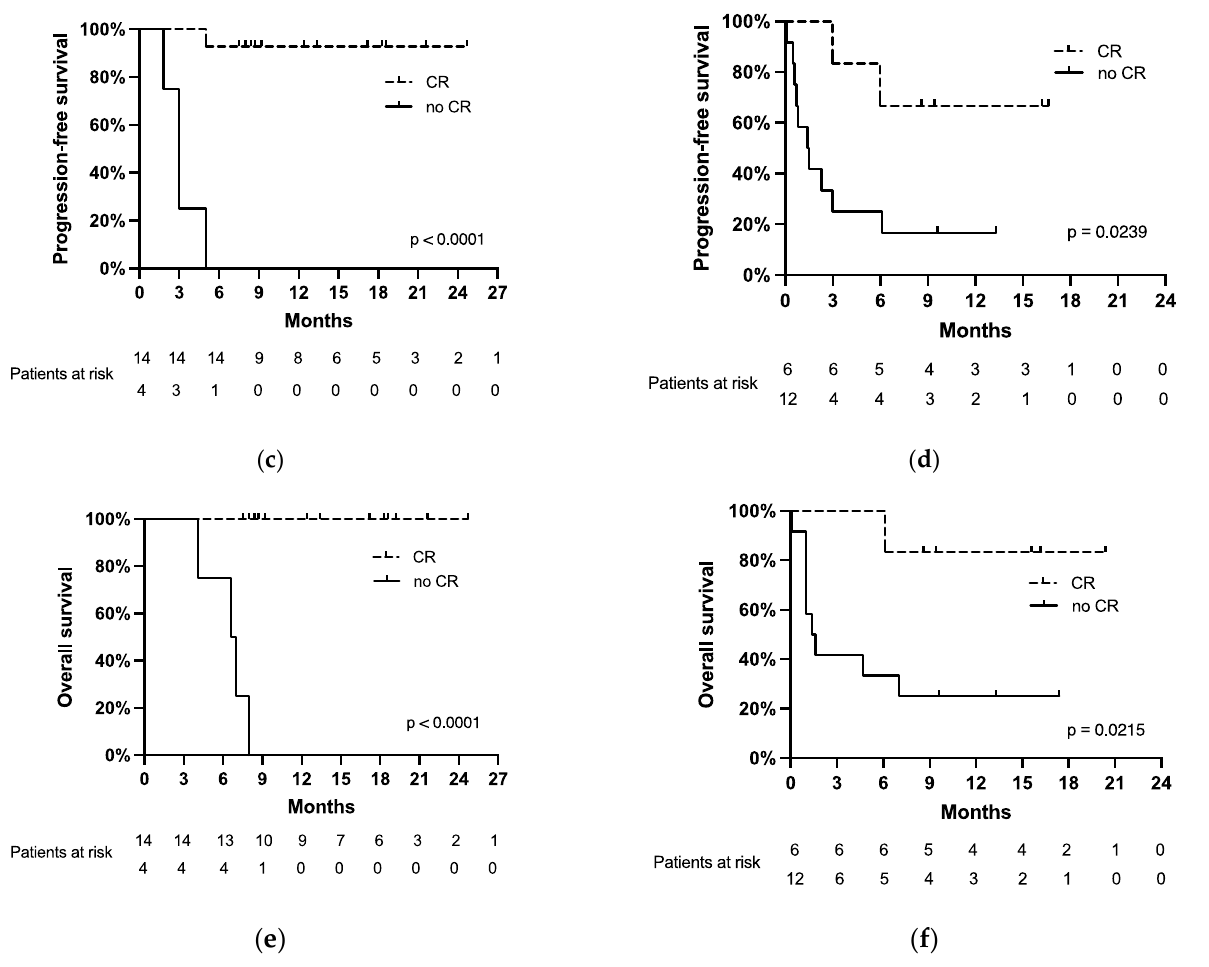
Figure 3. ( a ) Progression ‐ free survival and ( b ) overall survival of the patients with de novo and transformed DLBCL. Progression ‐ free survival of ( c ) patients with transformed lymphoma who reached a complete remission (CR) and who did not; and ( d ) of patients with de novo lymphoma who reached a CR and who did not. Overall survival of ( e ) patients with transformed lymphoma who reached a CR and who did not and ( f ) of patients with de novo lymphoma who reached a CR and who did not.